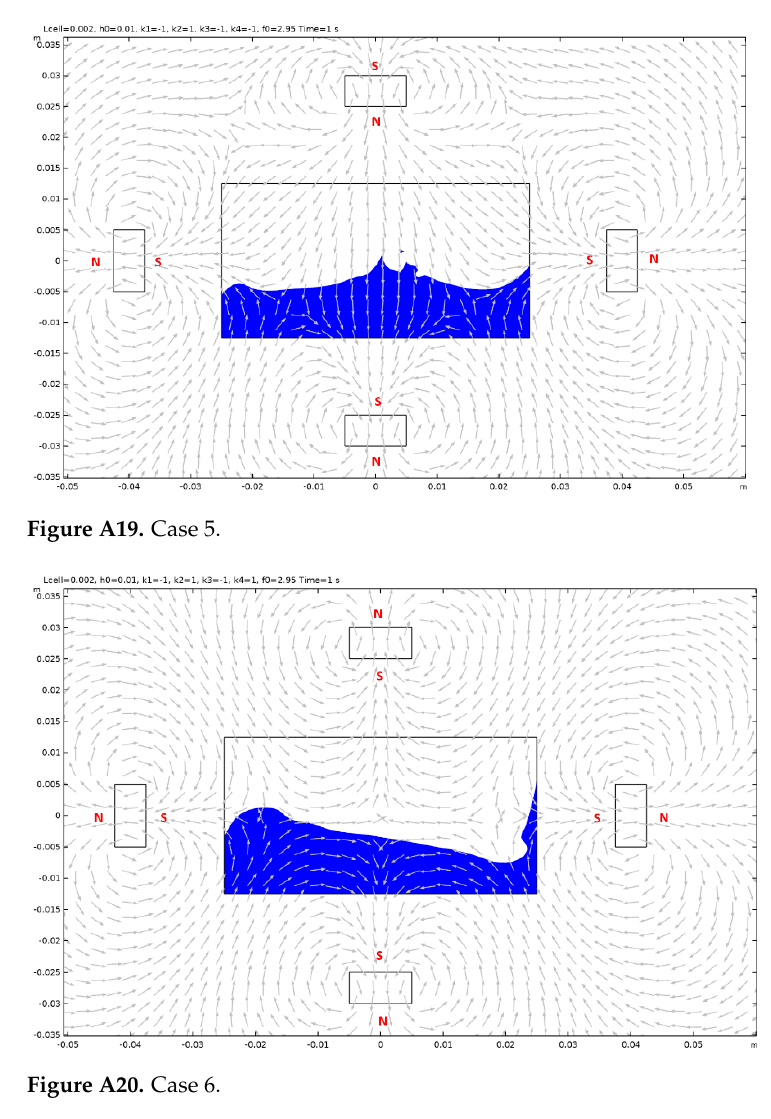
Figure A18. Case 4.